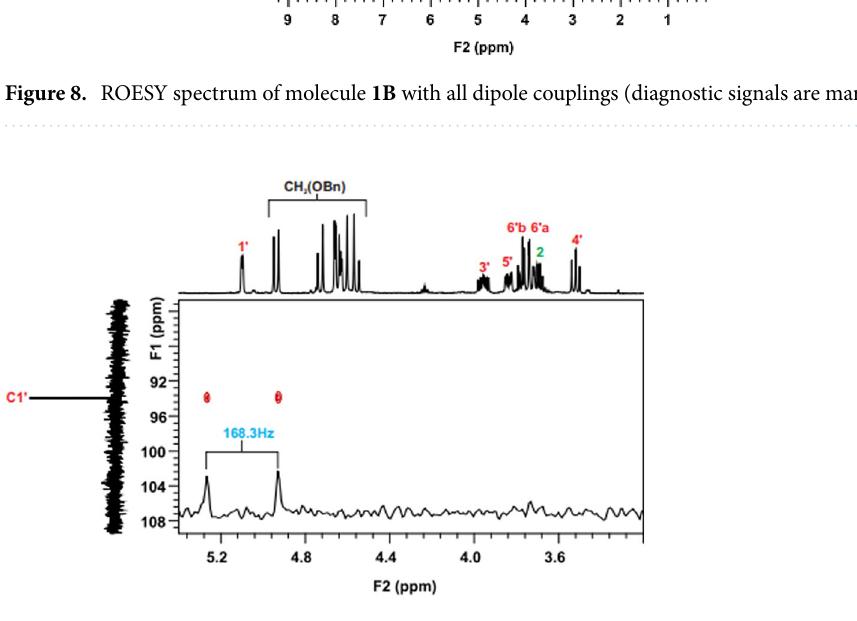
Figure 9. HSQC-nd spectra with the value of the 1 J C–H coupling constant for molecule 2C —alpha